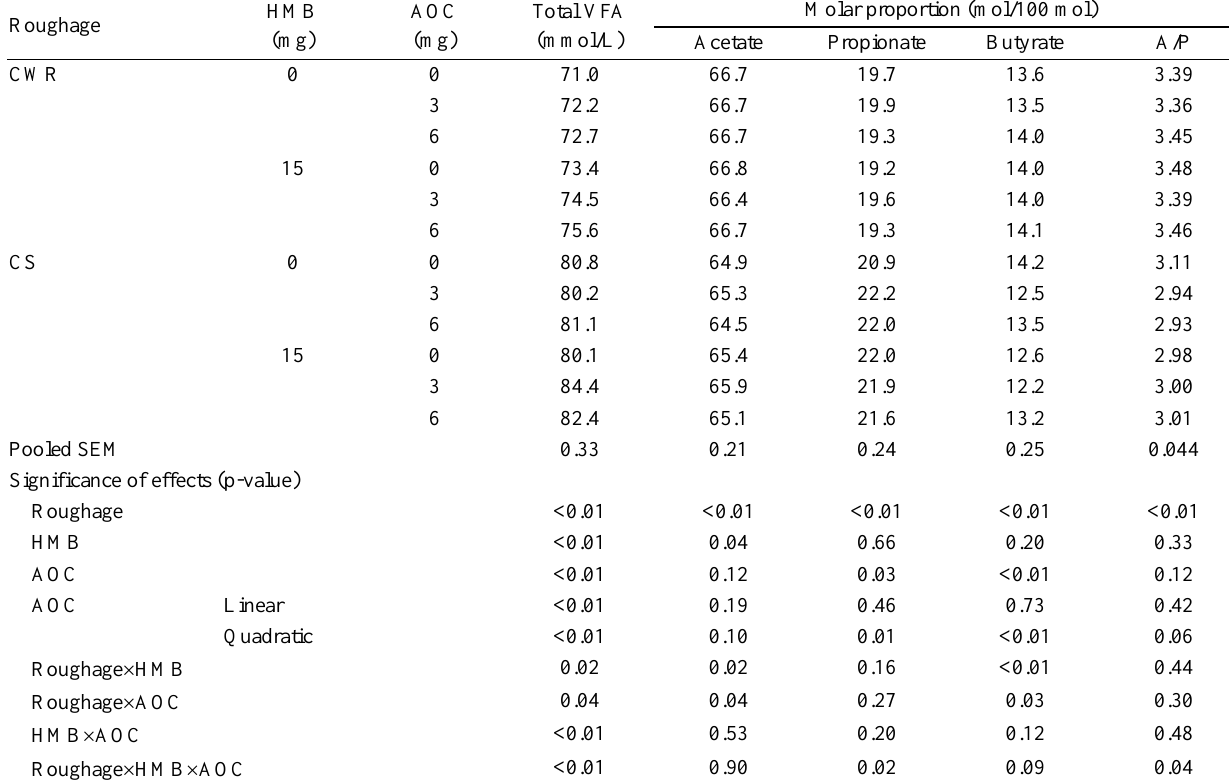
Table 5. Effects of AOC and HMB on total VFA and individual VFA at 24 h incubation for different roughage sources Roughage